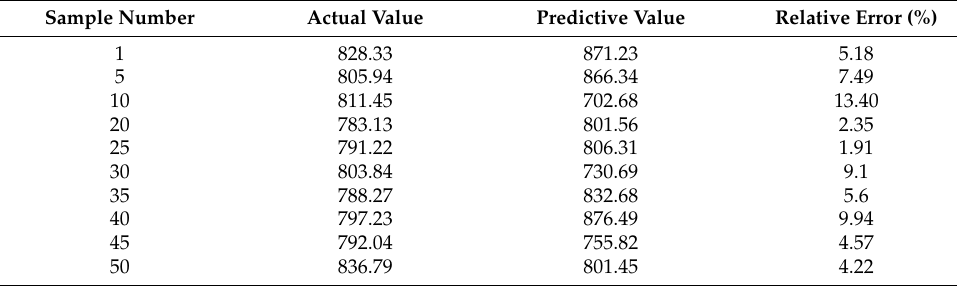
Table 11. Semiphysical simulation model prediction